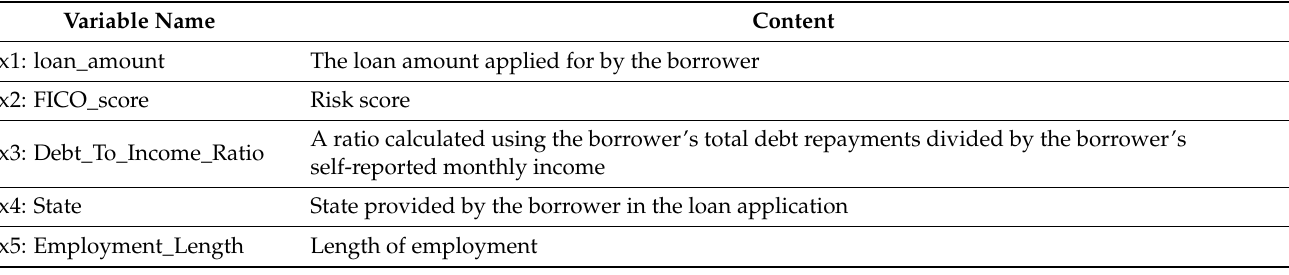
Table 1. Variable descriptions of the rejected loan applicants.